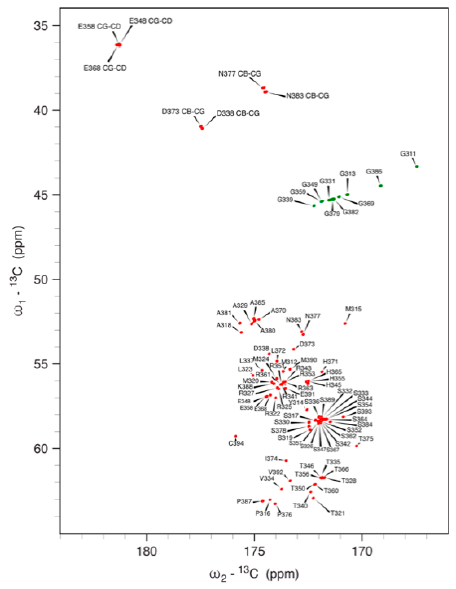
Figure 6. 700 MHz (16.4 T) 2D CACO spectrum obtained by 13 C direct detection, acquired at 298 K on samples of 13 C, 15 N labeled h NDRG1-C, at pH 6.5. The resonances are labeled according to the 13 C frequencies of the CO and CA nuclei of each amino acid, except for the signals for the side chains of Asp and Glu residues, for which the CB-CG and CG-CD are explicitly indicated.